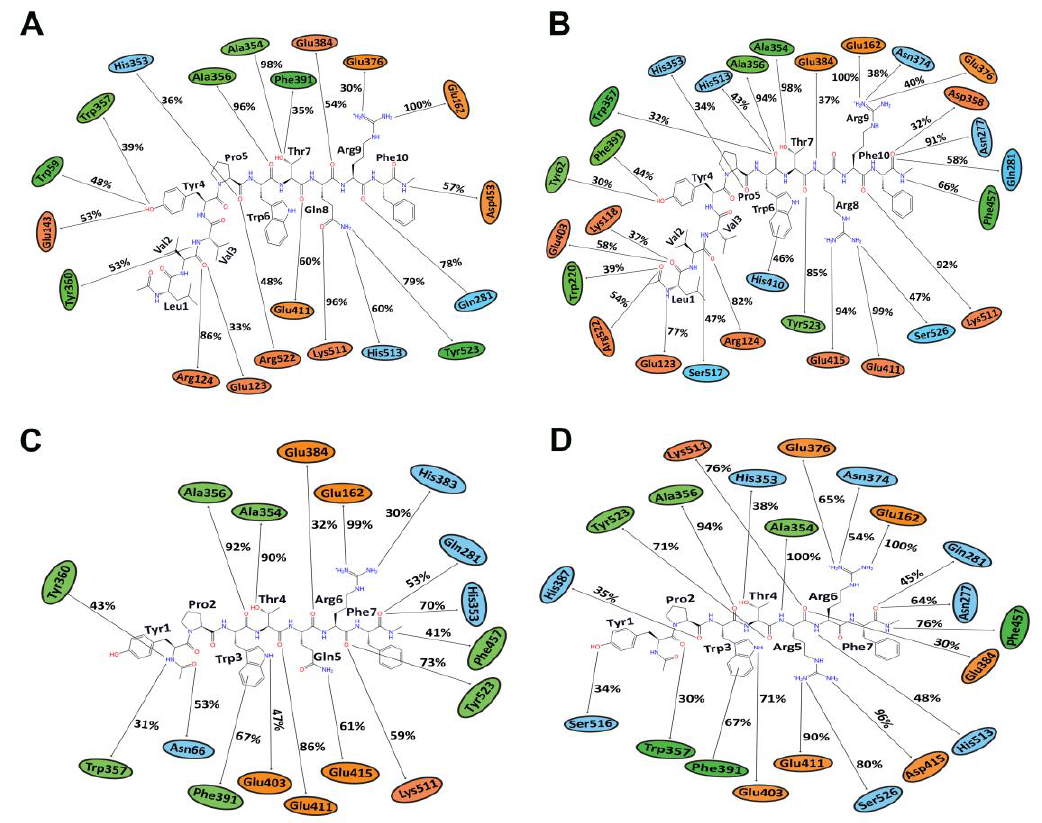
Figure 5. The average (from three runs) percentage of equilibrated simulation time during which various residues of hemorphin peptides interacted with residues of ACE. For this, the first 30 ns of each run was discarded. Orange, green, and blue colors represent charged, hydrophobic and polar amino acids, respectively. ( A ) Simulations of ACE-LVVYPWTQRF complex; ( B ) Simulations of ACE-LVVYPWTRRF complex; ( C ) Simulations of ACE-YPWTQRF complex; and, ( D ) Simulations of ACE-YPWTRRF complex.